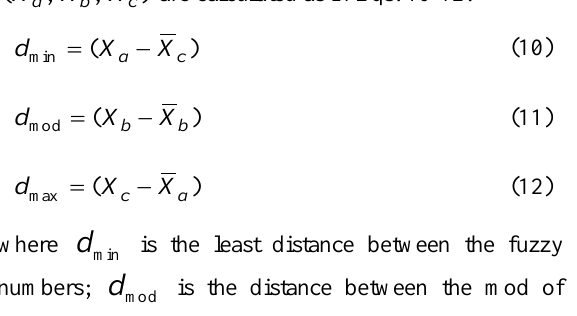
Fig. 4. The distances between fuzzy number and fuzzy mean : the fuzzy number is exactly on the left hand side of fuzzy